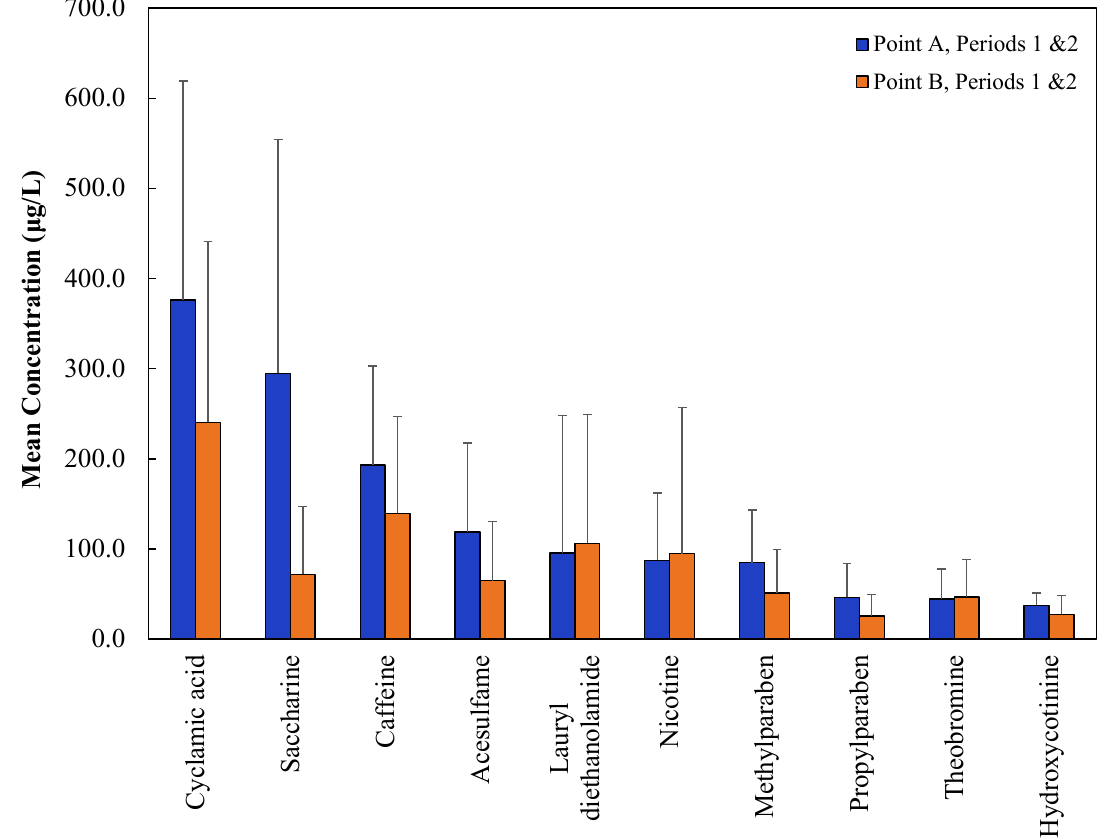
Figure 4. The 10 most abundant emerging contaminants in the HWW at Points A and B.